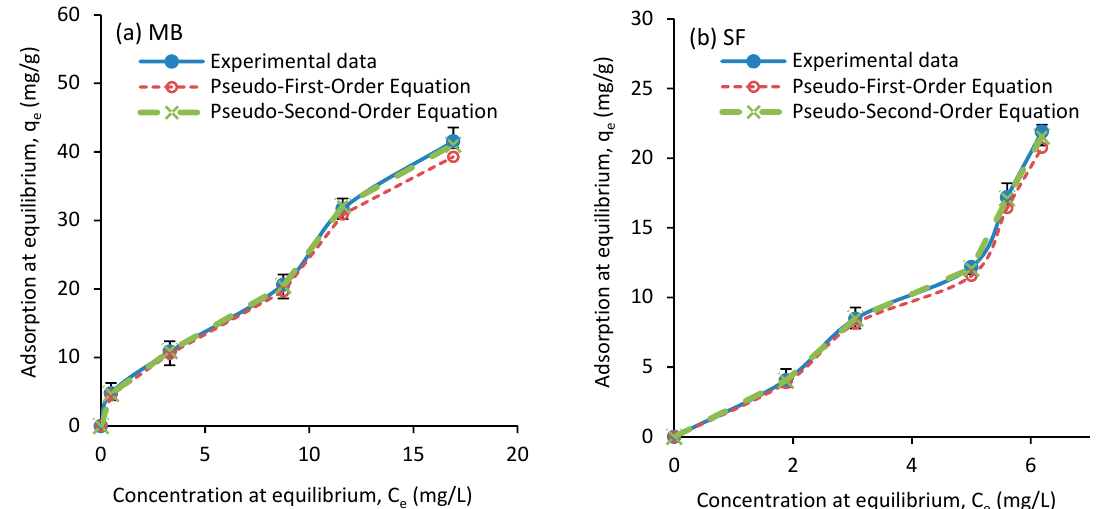
Figure 10. Experimental and pseudo first-order and pseudo second-order kinetic models data of equilibrium absorption for ( a ) MB and ( b ) SF as a function of adsorbent dose.